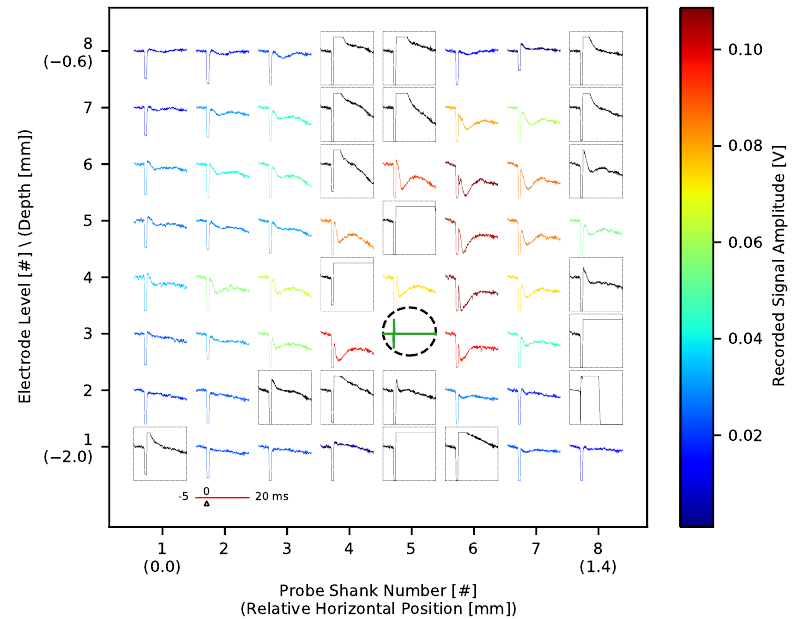
Figure 28. Average ( n = 10) evoked potential responses to current stimulation with charge-balanced bipolar pulse of amplitude 5.6µA for all MEA sites placed in a rat barrel cortex (the deepest electrodes were placed 2mm below cortical surface). The stimulating site was marked with a circle—the signal inside is the representation of the applied stimulation pulse (the timescale is the same as recorded signals, the amplitude scale is arbitrary). We can see that LFP response starts immediately after the end of stimulus and reaches the maximum after ∼ 5ms. Several MEA sites exhibited strong artefacts shortly after stimulation pulse application (i.e., post-stimulus level 20mV above the mean signal value before the pulse)—these were marked with rectangles and waveforms inside were clamped. Each average response is 25ms long with 5ms pre-trigger LFP and its amplitude is colour-coded except for sites with stimulation artefacts (note that gain correction was not